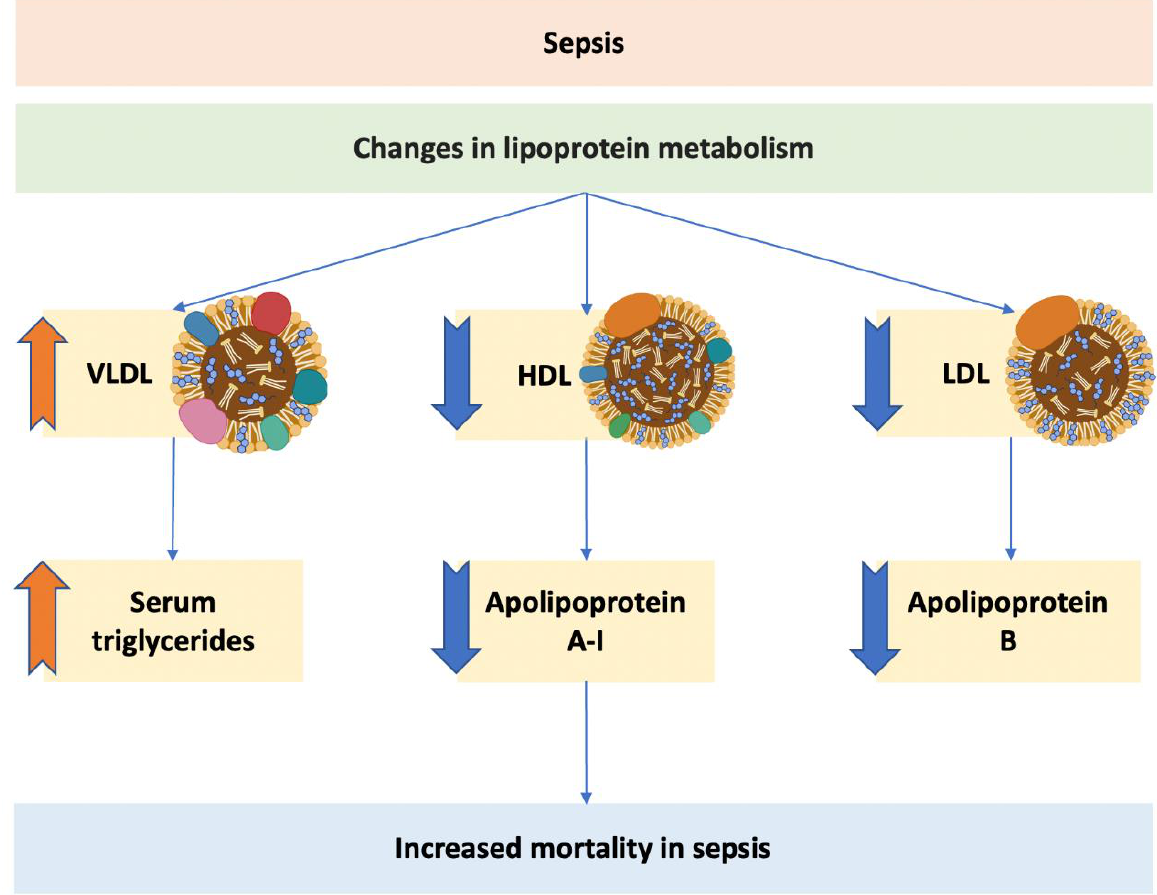
Figure 2. Bidirectional relationship between sepsis and lipoprotein metabolism . The decrease in HDL is not only a consequence of sepsis but also an aggravating factor, leading to more severe sepsis and increased sepsis-induced mortality.